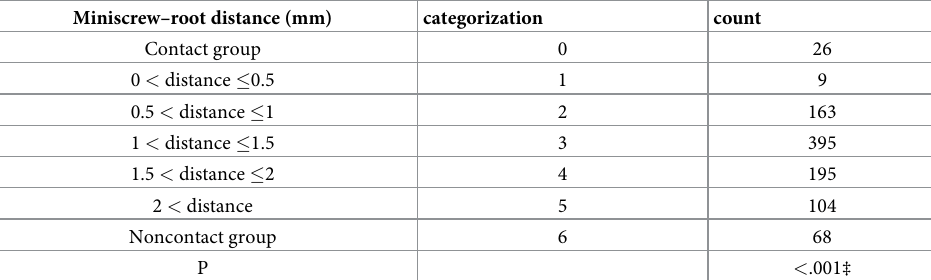
Table 2. Categorization of miniscrew–root distance: Measurable values and non-measurable values (contact group, noncontact